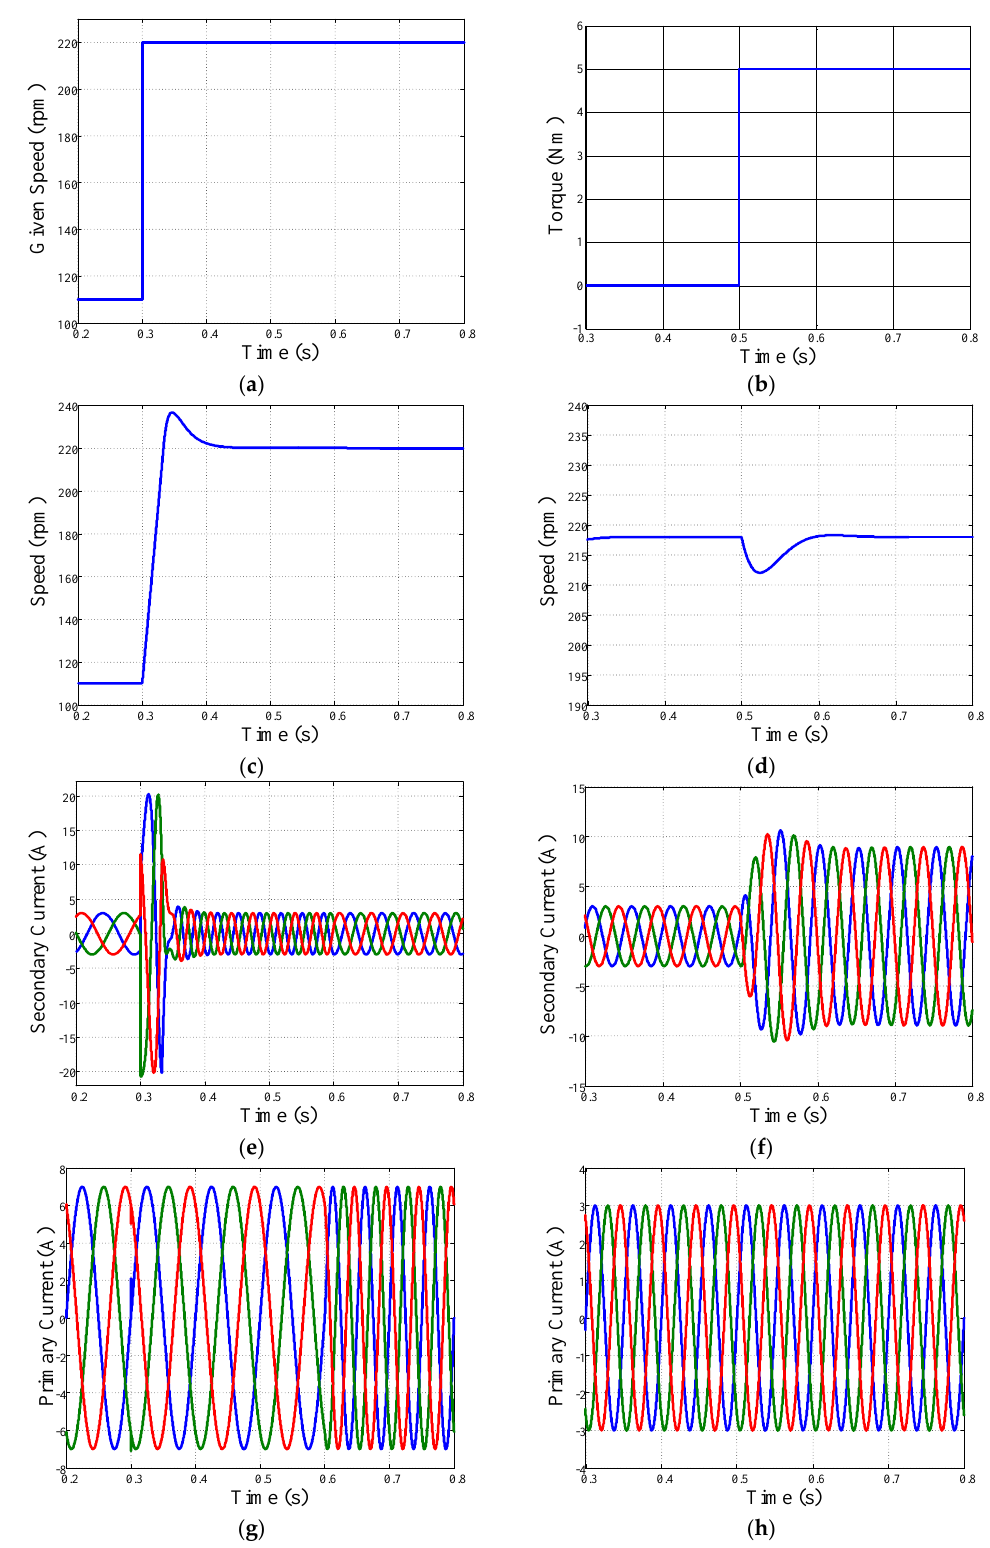
Figure 15. Simulation results of the AC excitation control for the DSFM motor: ( a ) curve of the given speed variation. ( b ) curve of the load torque variation; ( c ) speed curve for speed varying from 110 to 220 rpm; ( d ) speed curve for torque varying from 0 to 5 Nm; ( e ) secondary current curve for speed varying from 110 to 220 rpm; ( f ) secondary current curve for torque varying from 0 to 5 Nm; ( g ) primary current curve for speed varying from 110 to 220 rpm; and ( h ) primary current curve for torque varying from 0 to 5